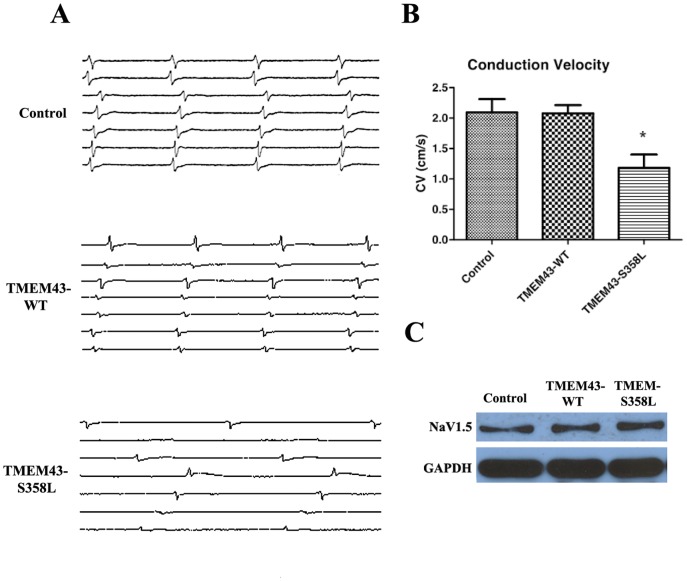
Effects of TMEM43 on conduction velocity and sodium channel expression.
A. Electrograms recorded from adjacent MEA electrodes in HL-1 cell cultures. All cells beat spontaneously. Control and TMEM43-WT cells beat with a regular, synchronous rhythm. TMEM43-S358L cells beat with an irregular, comparatively slowed rhythm. B. Average velocity illustrating a decrease in conduction velocity of the TMEM43-S358L cells (1.2 cm/s) compared to control cells (2.5 cm/s) and TMEM43-WT cells (2.1 cm/s) (n = 7 control, n = 6 TMEM43-WT and n = 6 TMEM43-S358L, * p<0.01). All results are representative of six independent culture experiments. C. Western blot demonstrating expression of NaV1.5 in control, TMEM43-WT and TMEM43-S358L cells. GAPDH was used as a loading control. Rabbit polyclonal NaV1.5 antibody specifically detected sodium ion channel (NaV1.5) expression in all three cell types. Neither wild-type nor mutant TMEM43 altered the NaV1.5 expression. All results are representative of three independent Western blot experiments.